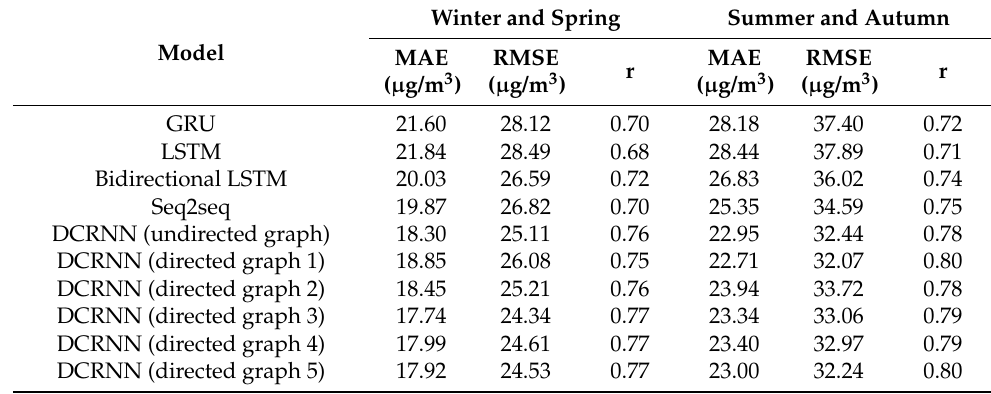
Table 2. Model comparison between the DCRNN model and baseline models in the ozone forecasts.